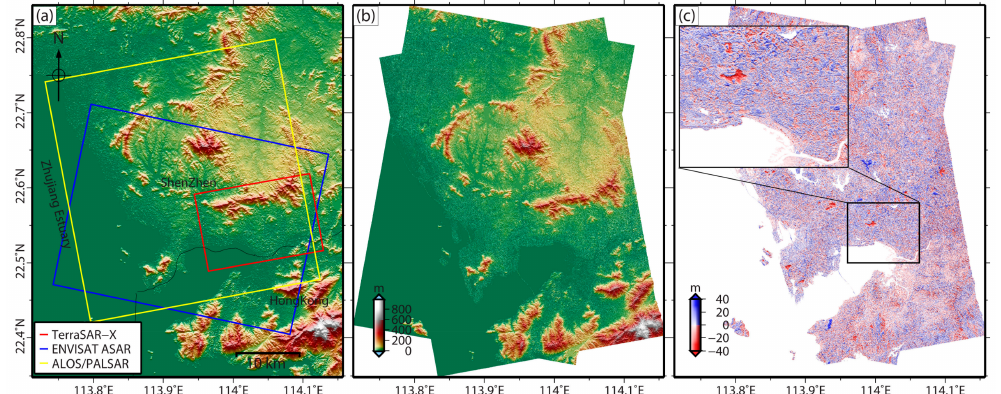
Figure 1. Data coverage: ( a ) SRTM-1arc DEM with a resolution of 30 m in 2000. The red, black and yellow rectangles represent the TerraSAR-X, ENVISAT ASAR and ALOS/PALSAR collected in this paper, respectively. ( b ) Fused TanDEM-X DEM with a resolution of 5 m in 2014. ( c ) Difference between TanDEM-X DEM and SRTM-1arc DEM.